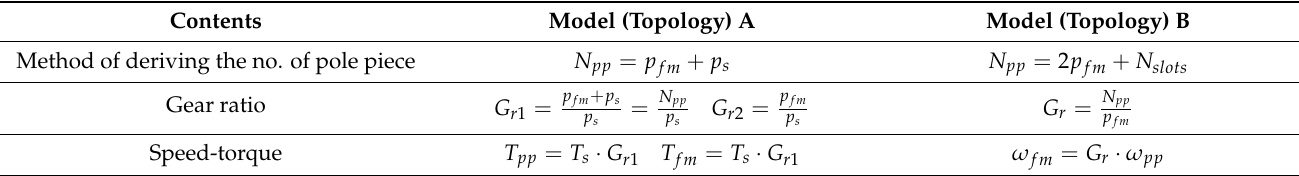
Table 4. Design Topologies of 45kW ‐ class MG ‐ PMSM Design Model with Concentrated winding.